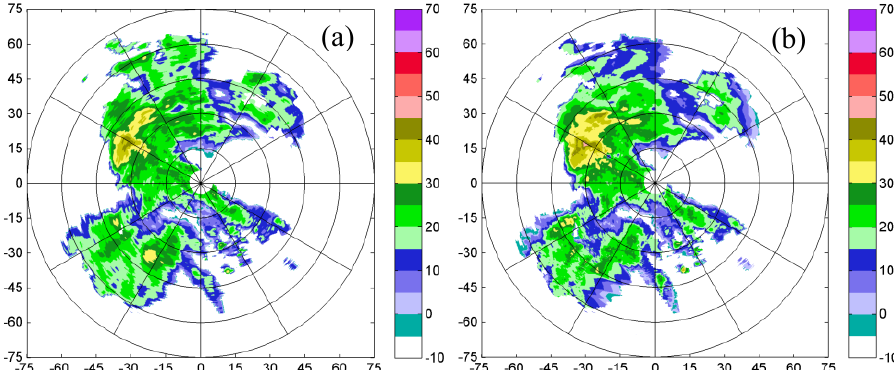
Figure 16. ( a ) Corrected reflectivity at X-band; ( b ) the intrinsic reflectivity at X-band.